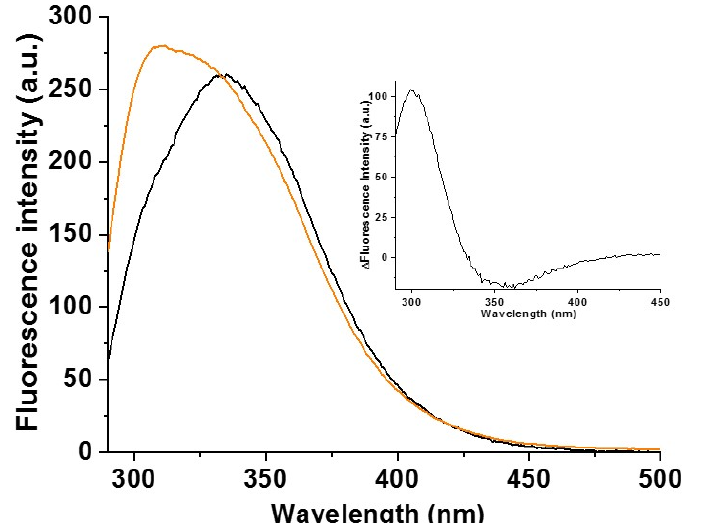
Figure 7. Fluorescence emission spectroscopy indicated that tyrosine 59 was not involved in cluster coordination in the C59Y BOLA3–GLRX5 complex. Fluorescence emission spectra of apo C59Y BOLA3–GLRX5 complex before (black) and after (orange) chemical reconstitution recorded upon excitation at 280 nm. In the inset, fluorescence emission difference spectrum (Δ) obtained by subtracting the spectrum of the chemically reconstituted hetero-complex from that of the apo hetero-complex.